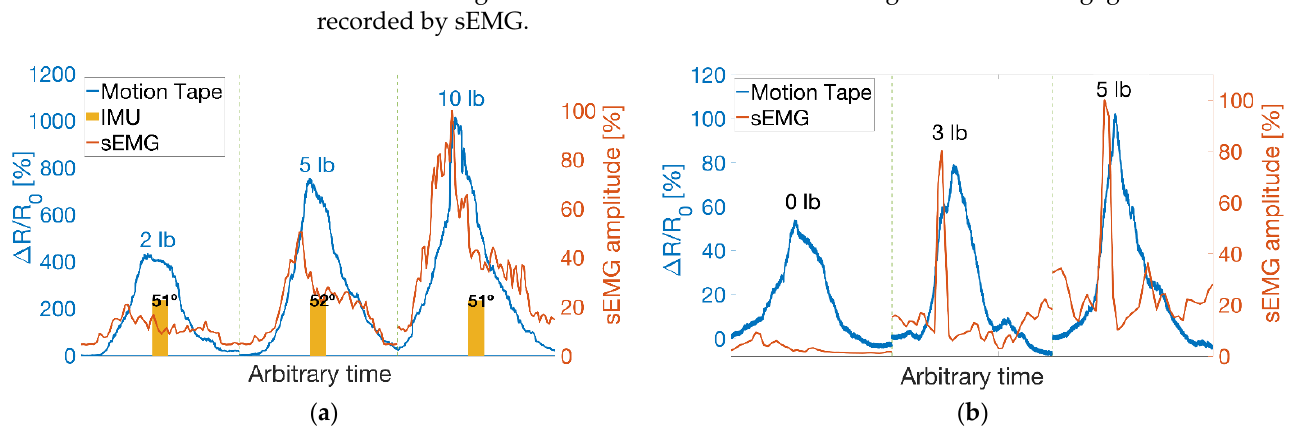
Figure 11. ( a ) Motion Tape Rn time histories are overlaid with sEMG measurements when a subject lifted 2, 5, and 10 lb dumbbells. ( b ) The biceps curl results from a different subject and test using 0, 3, and 5 lb weights are also shown.